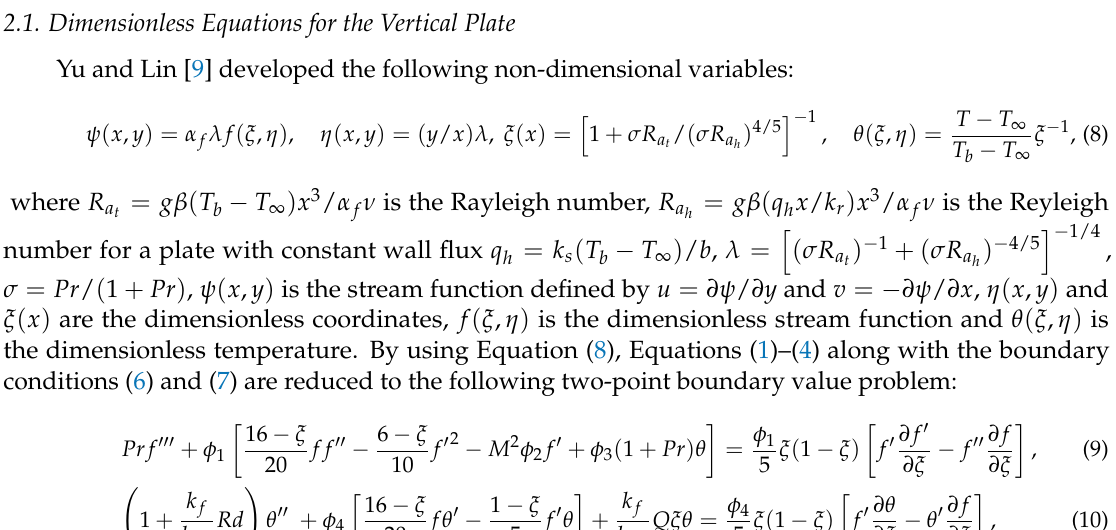
Figure 1. Physical model and coordinate system. ( a ) vertical plate; ( b ) horizontal